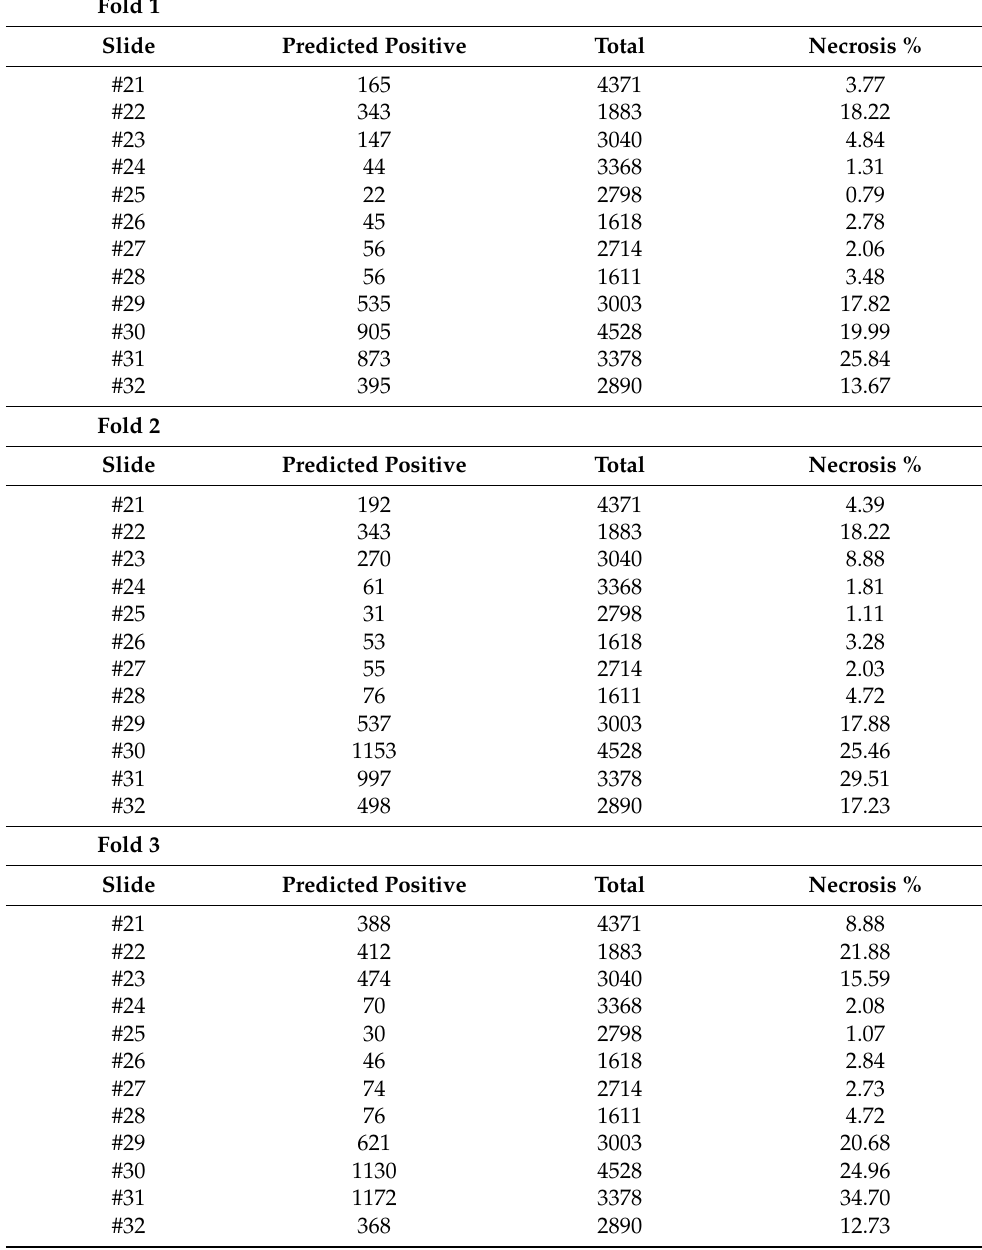
Table 4. Predicted positive labels and % of necrosis that the algorithm detected in each slide after